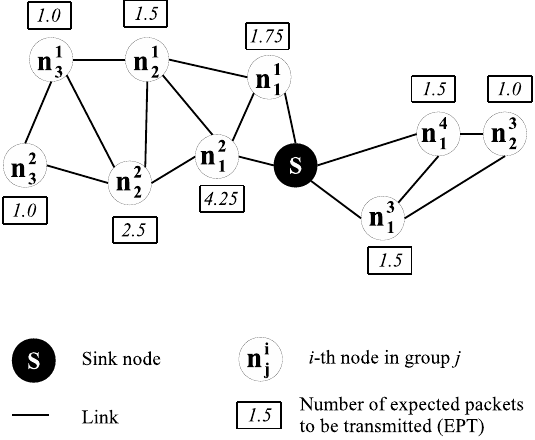
Figure 1. Example of group determination phase and expected packets to be transmitted.